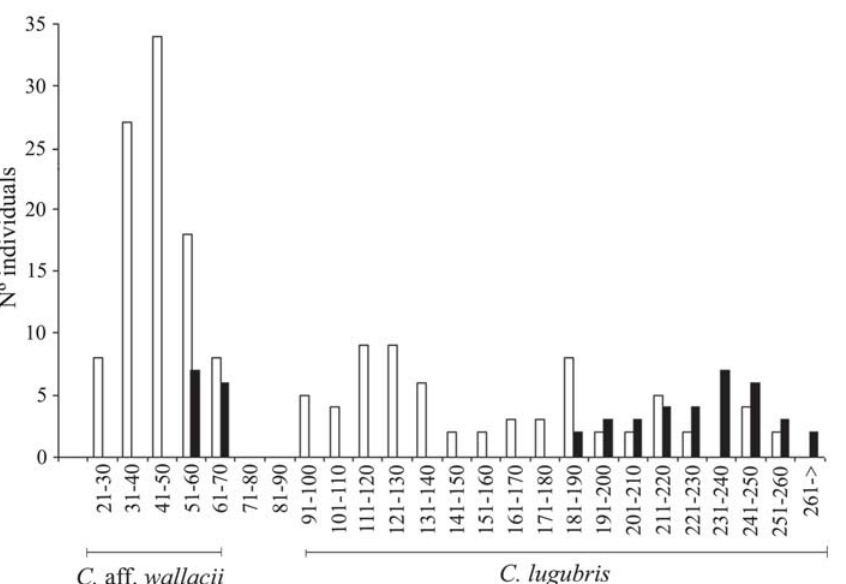
Fig. 4. Number of immature and mature gonads encountered in C . lugubris (a) and C . aff. wallacii (b) of different size classes during the dry season. (black barra) Mature (gonad state > 3); (white barra) immature (gonad state 1-2). C . lugubris (n = 102), C . aff. wallacii (n =